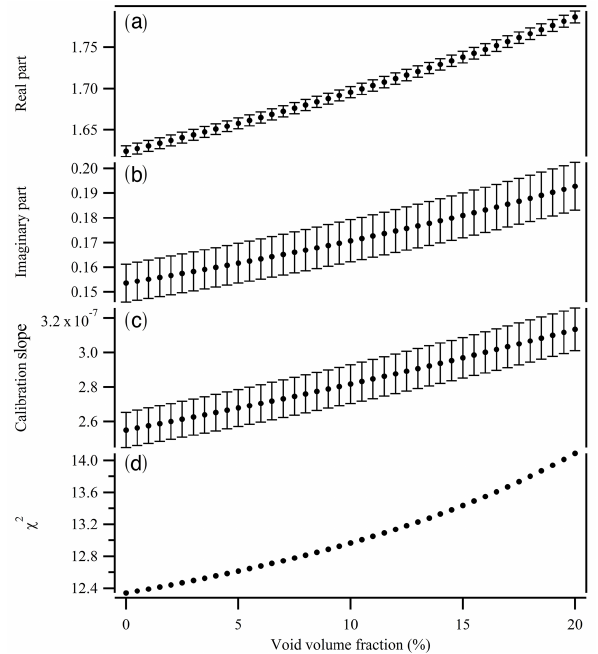
Figure 6. (a) and (b) Complex RI of the “pure” nigrosin component, reanalyzed from SE measurement, assuming a mixed nigrosin–air film with increasing homogenous air voids fraction. (c) Calculated PA-CRD-S nigrosin, aerosol-phase calibration slope and (d) associ- ated χ 2